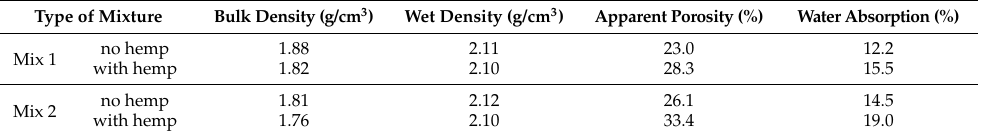
Table 10. Density